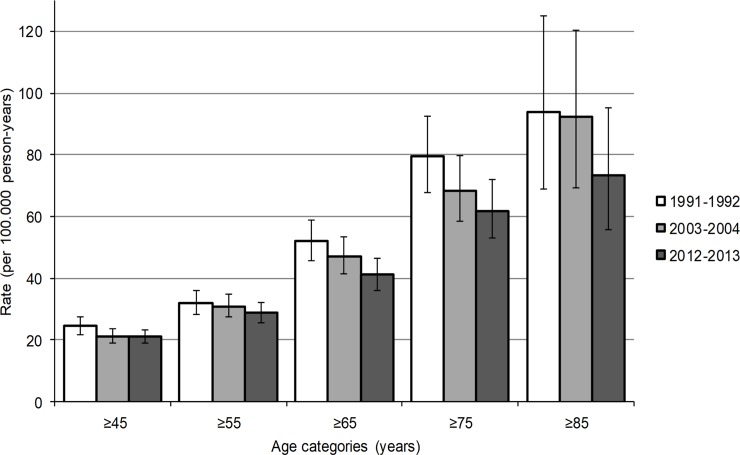
Crude incidence rate of major LEA for the three historic cohorts, by age categories.Error bars are 95% CI.